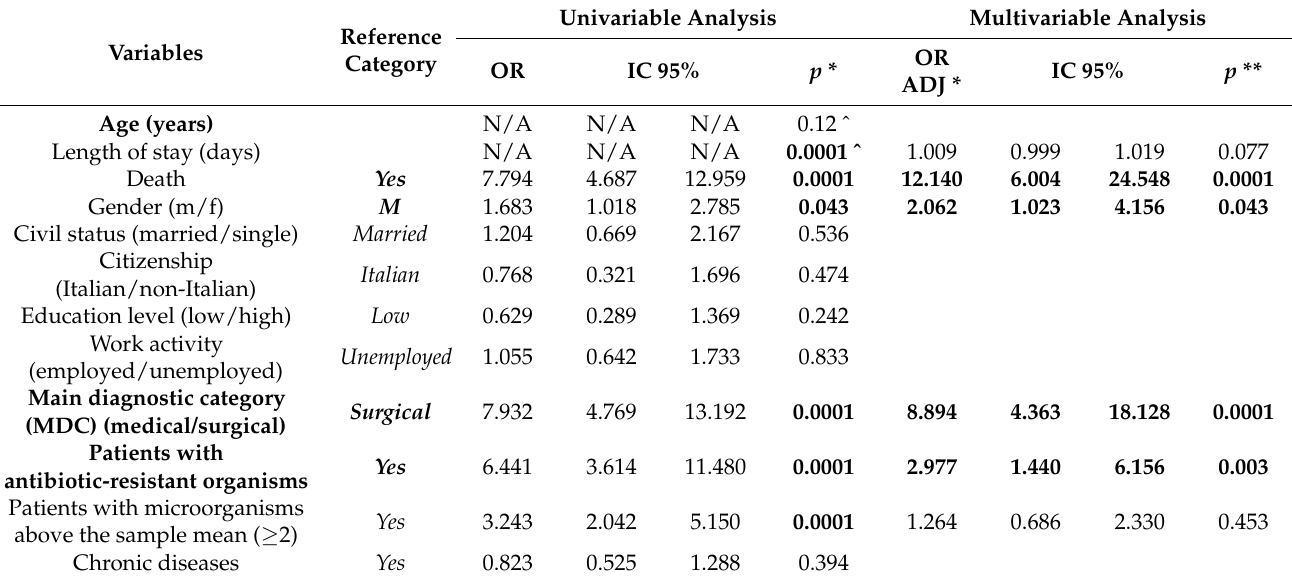
Table 4. Crude and adjusted ORs (and 95% CI) of intubation/ventilation, according to relevant